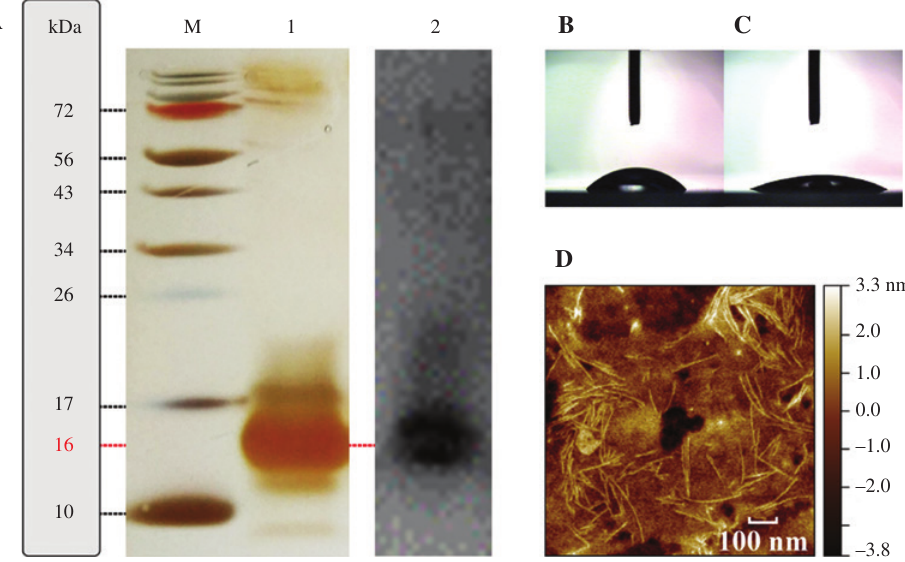
Figure 5: Expression, purification and identification of the HGFI. (A) Identification of purified HGFI based on SDS-PAGE. Lane M, molecular-mass markers. Lane 1, silver stain of HGFI. Lane 2, Western blot of HGFI using HGFI antibody. WCA on (B) an ordinary bare glass substrate and (C) an HGFI-coated ordinary glass substrate. (D) AFM observation of HGFI-modified mica interface.